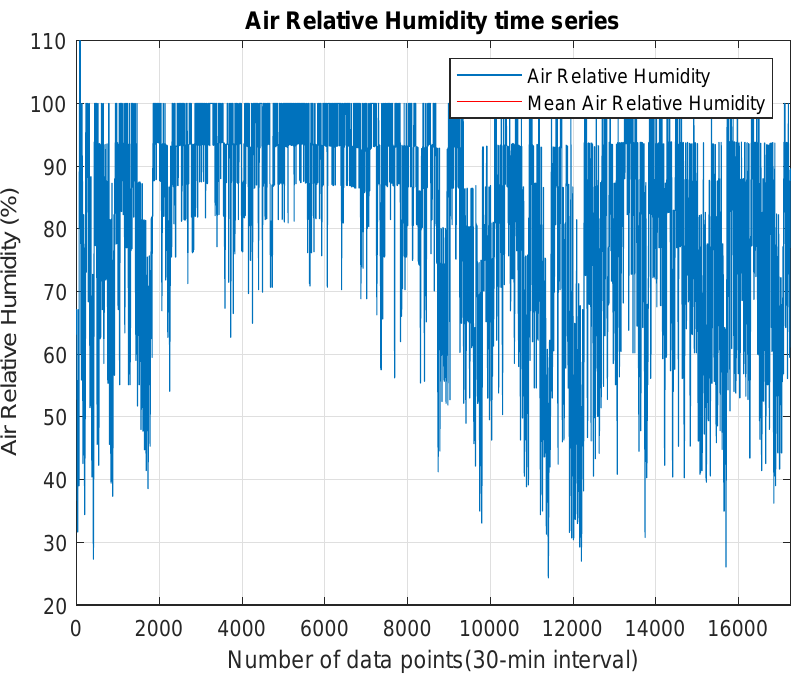
Figure 14. The portraits of air relative humidity in OSWFs in Yangshan port, Shanghai from 22 August 2017 to 22 August 2018.